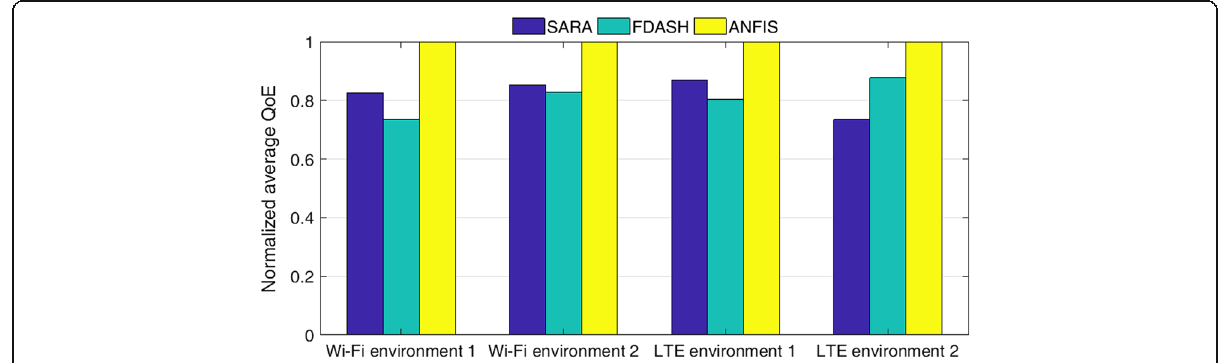
Fig. 14 Comparison of QoE in each simulation